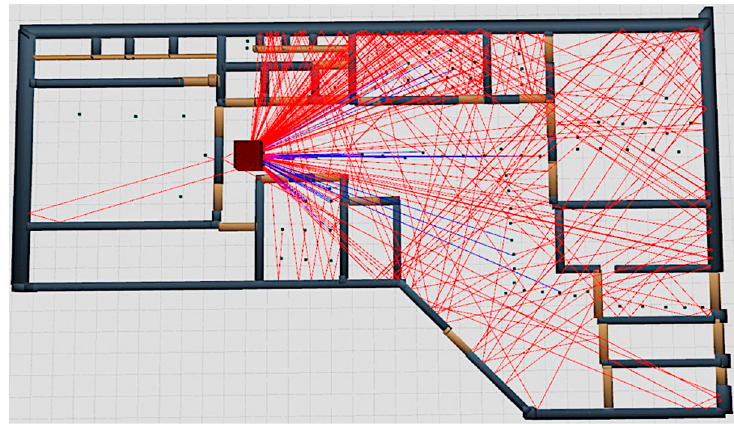
Figure 8. 3-D ray tracing (RT) simulation of WCC P15a layout using SBRT method.